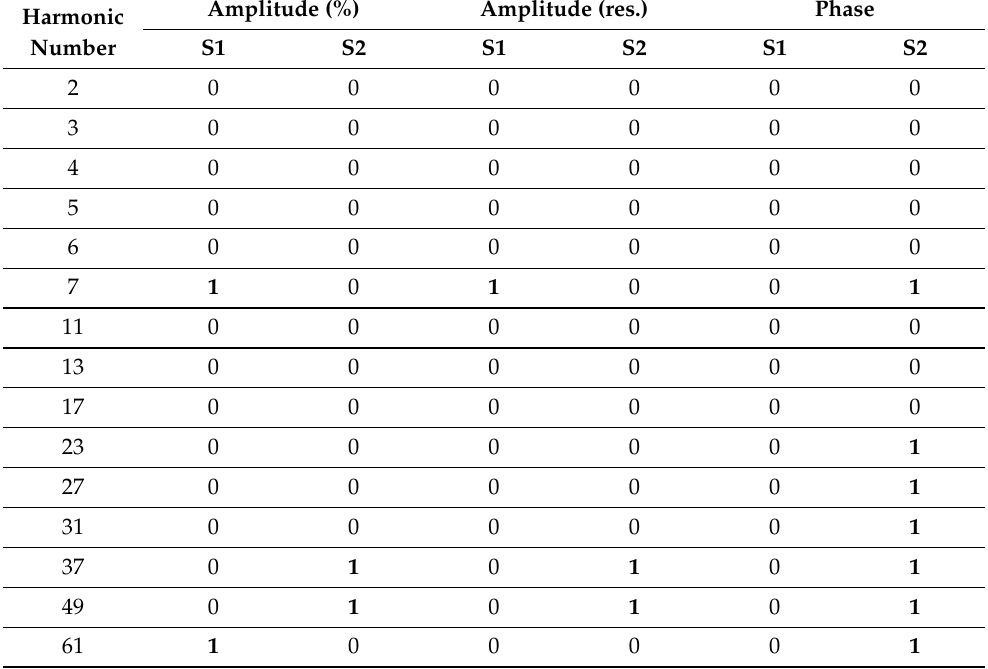
Table 2. AD results for inrush event distribution as seen by S 1 and S 2 . Harmonic